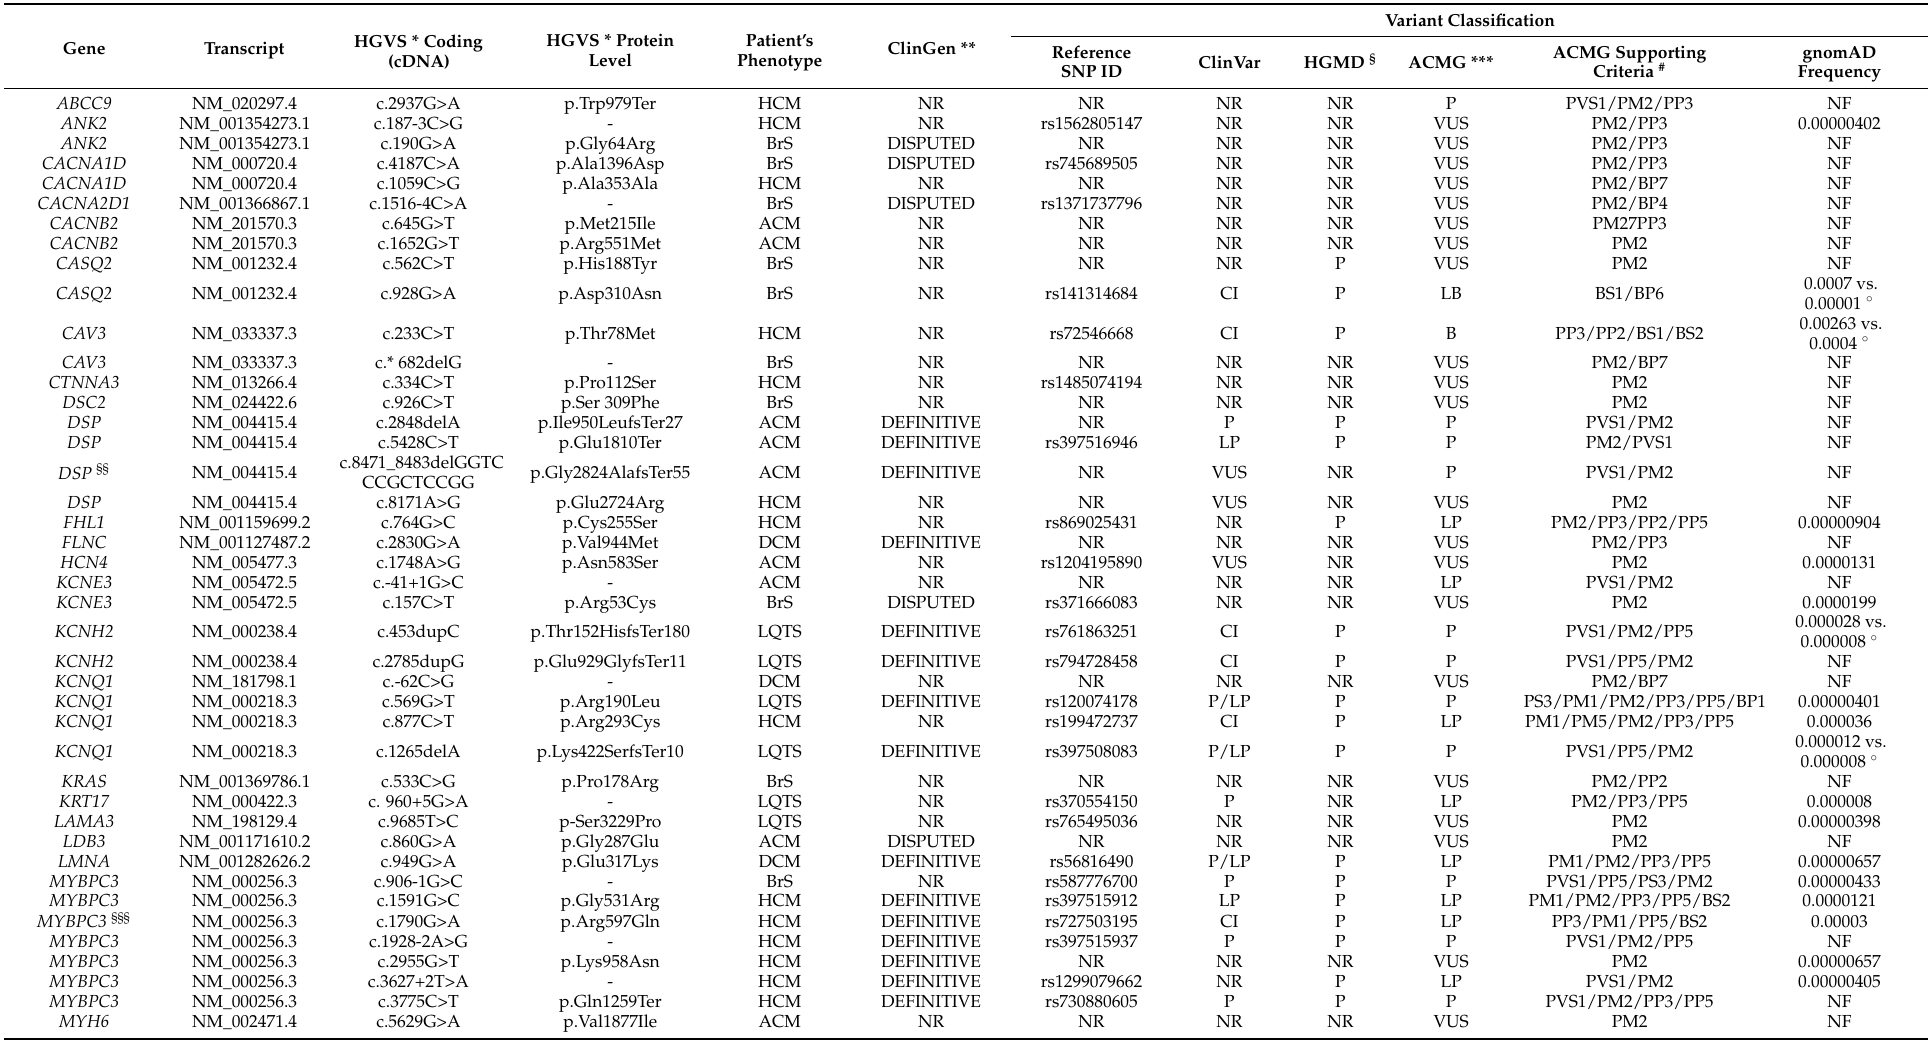
Table 1. List of genetic variants (n = 82) identified in the 133 patients of the study